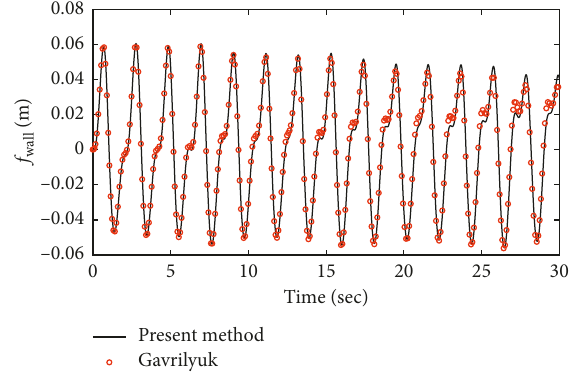
Figure 7: Time history of the surface wave height on the wall at θ � 0 for ω � 5 rad/s.